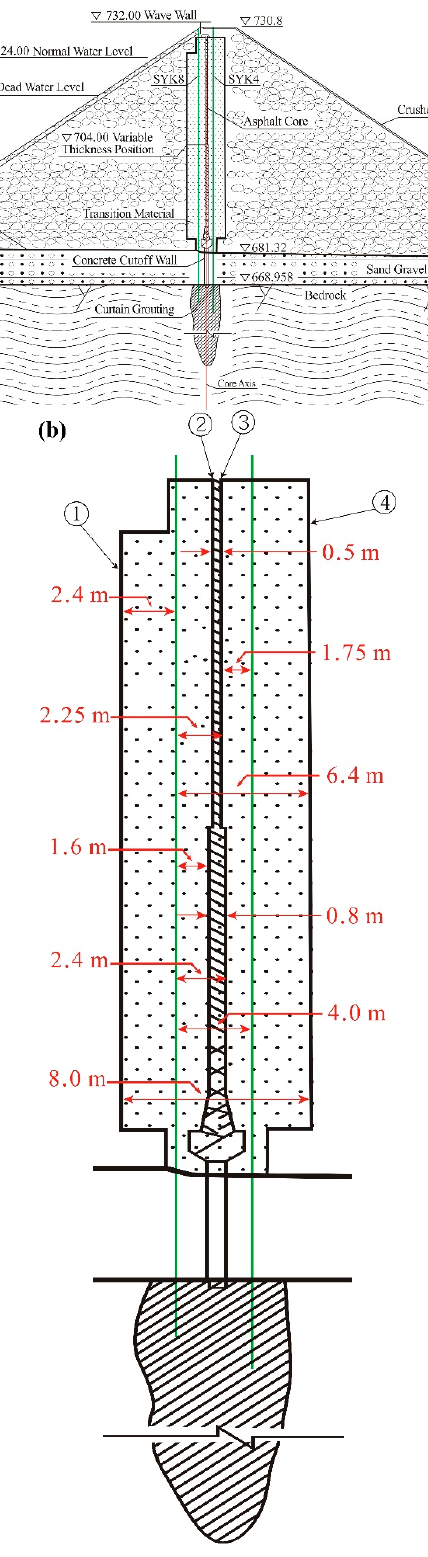
Figure 2. ( a ) Cross section of the rock-filled dam under investigation. ( b ) The enlarged part of the core